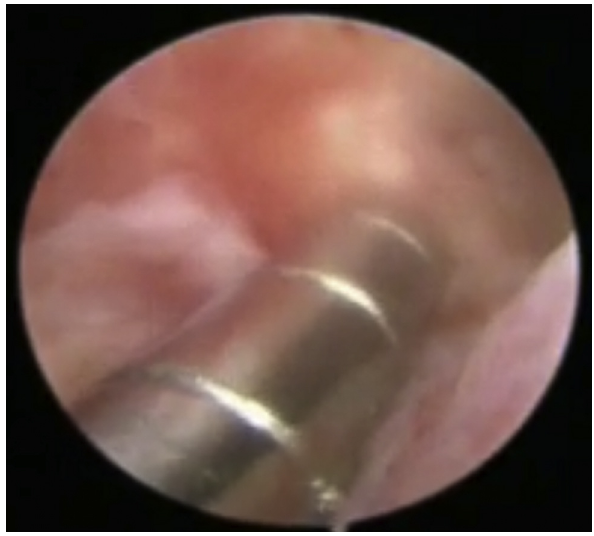
Figure 5 Straight probe into posterior recess of TMJ mobiliz- ing the disk to its anatomical position, after adhesion removal.